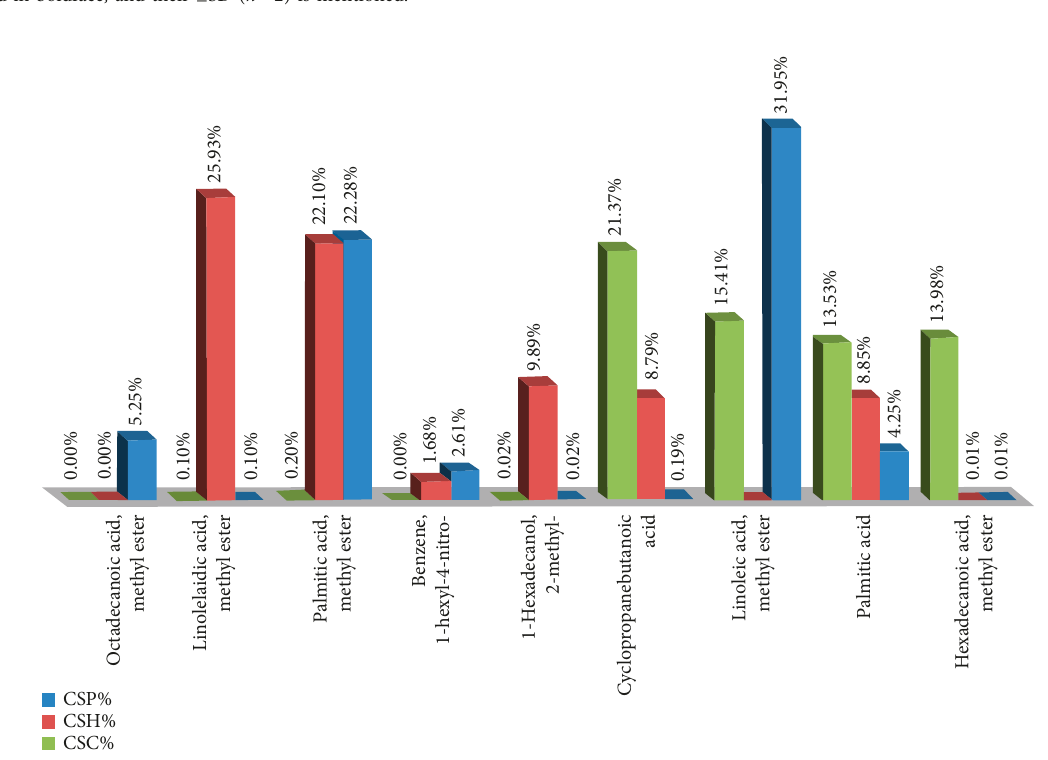
Figure 1: Chemical classes found in the oils of CSP � C. scolymus L. petal, CSH � C. scolymus L. heart, and CSC � C. scolymus L.